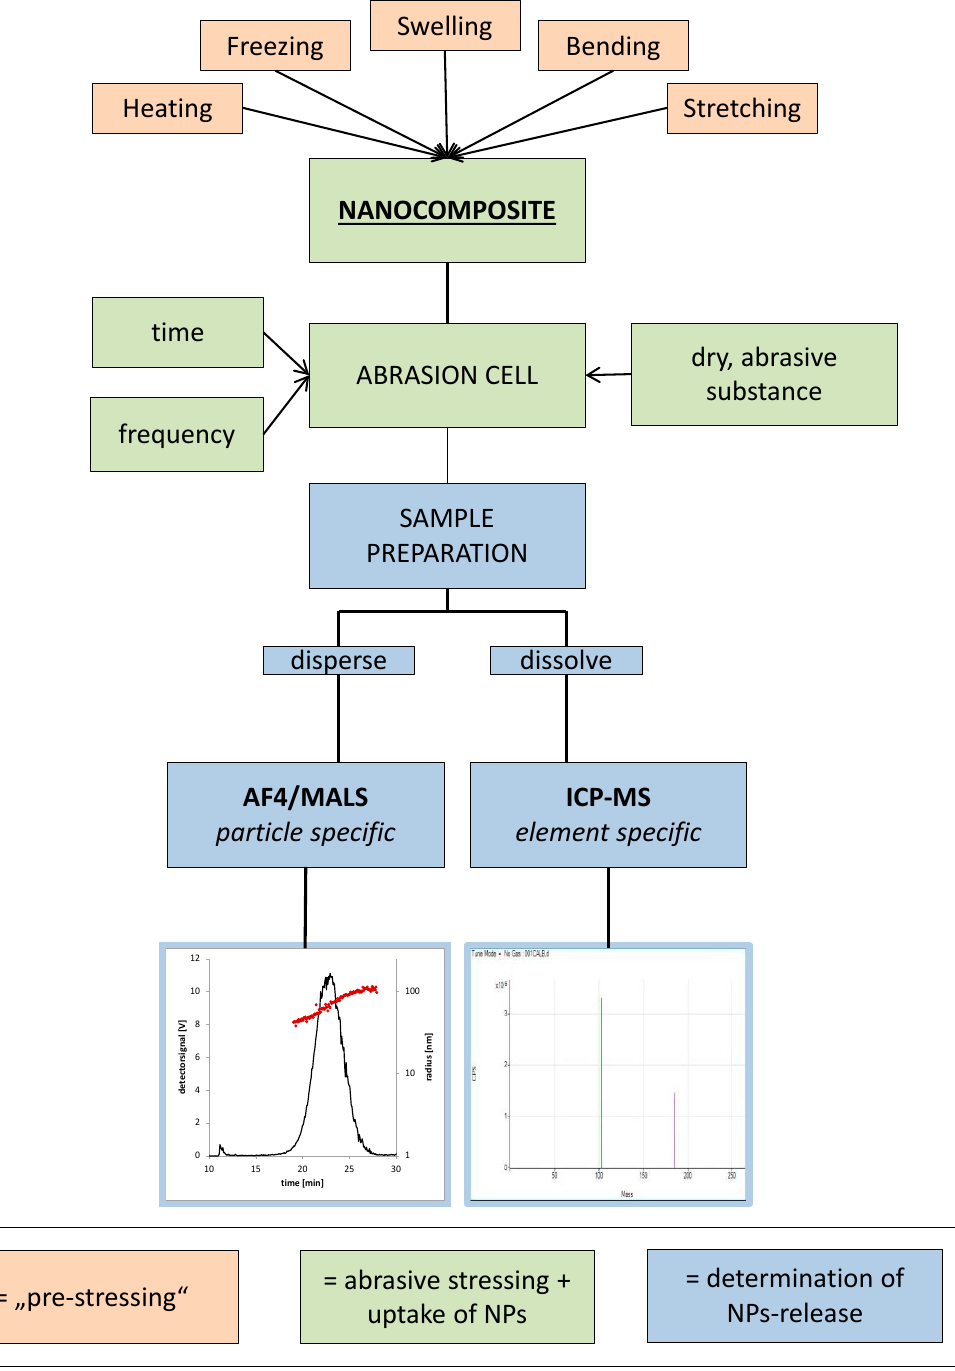
Figure 3. Overview workflow of abrasion